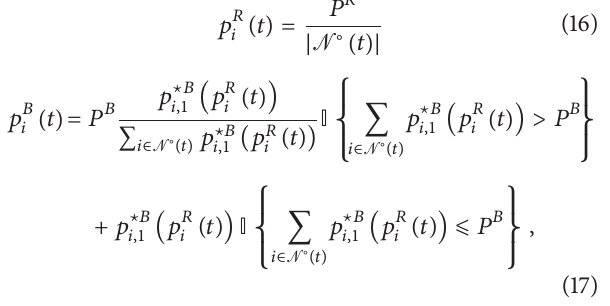
Algorithm 7 (equal relay power allocation and optimal pro- portional jamming power allocation (EROptPJam)).